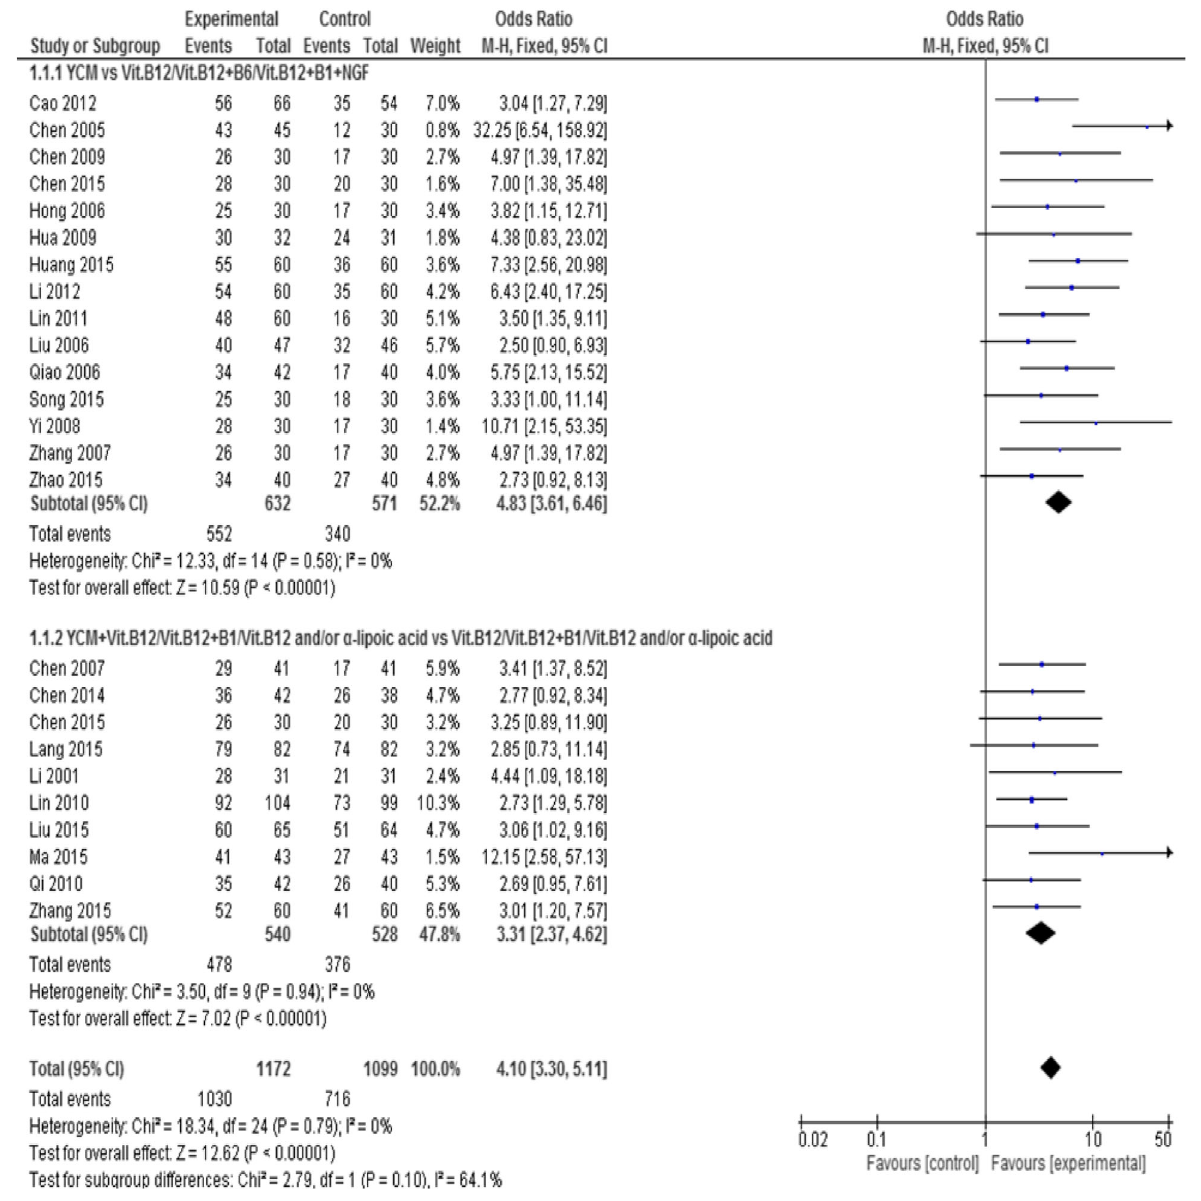
Fig. 5 Forest plot of total efficacy rate of YCM on diabetic peripheral